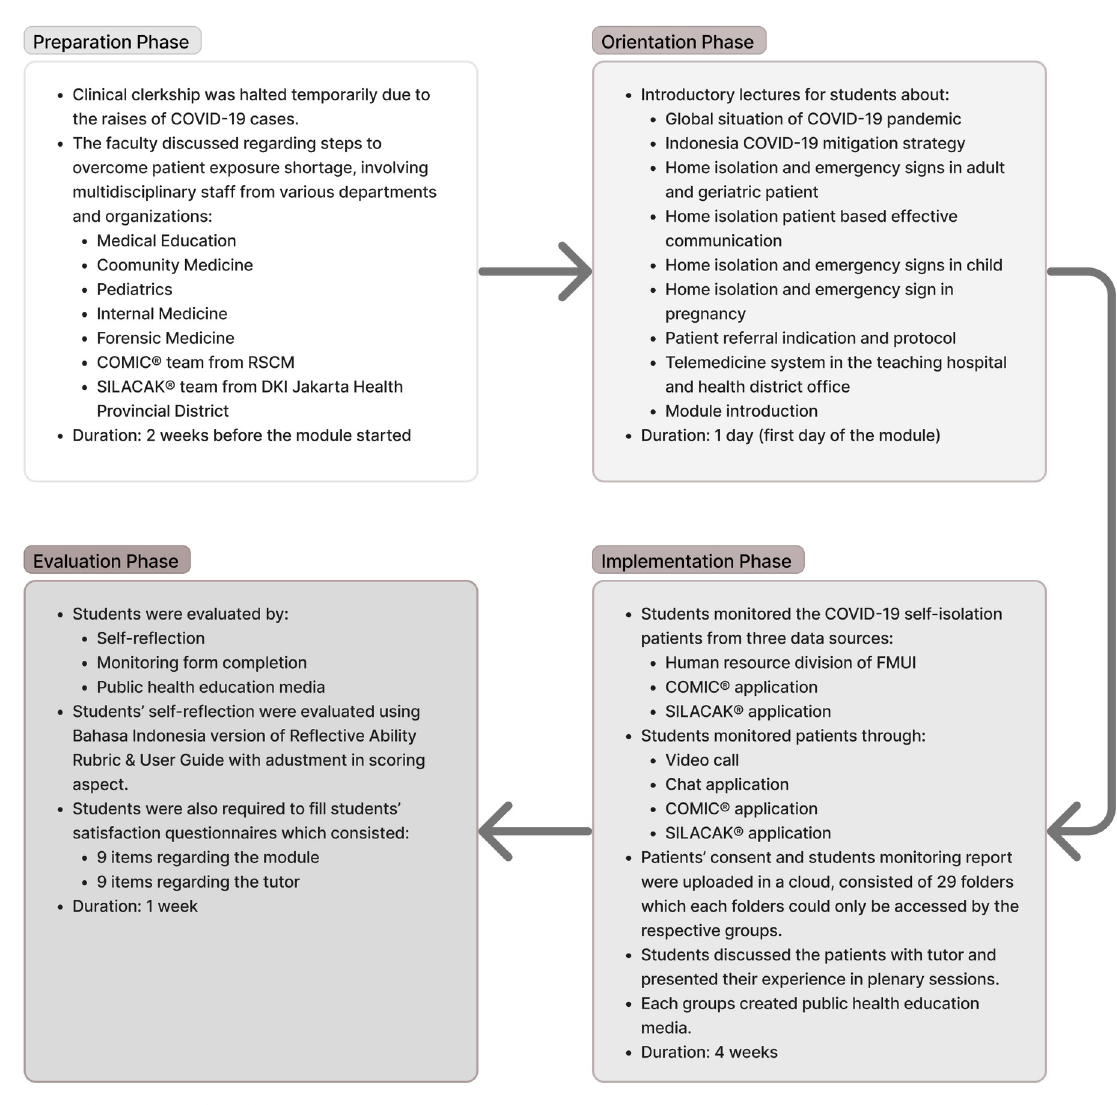
were identified from three data sources: the human resource division of FMUI and student contact, the COVID-19 Monitoring and Information Center (COMIC 1 ) application, and the Sistem Informasi Pelacakan (SILACAK 1 ) application. Telemonitoring was performed through telemedicine, i.e., video call, chat application, COMIC 1 (developed by Dr. Cipto, Mangunku- sumo Hospital, a teaching hospital affiliated with FMUI), and SILACAK 1 (a COVID-19 trac- ing information system developed by the Ministry of Health, Republic of Indonesia). The monitoring process and flow of the module are provided in Fig 2. Students were required to obtain each patient’s consent before monitoring. The patient data could only be accessed by the respective groups to ensure confidentiality. Before monitor- ing, students downloaded the self-isolation monitoring sheet provided in EMAS 1 . They were required to complete the sheet daily until the patients fulfilled the discharge criteria. The mod- ule team provided 29 folders that could only be accessed by the respective groups. Students